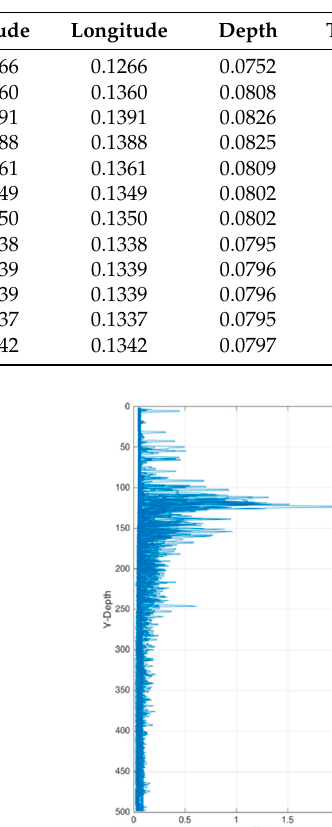
Table 3. Weights of each attribute when forming thermocline monthly.